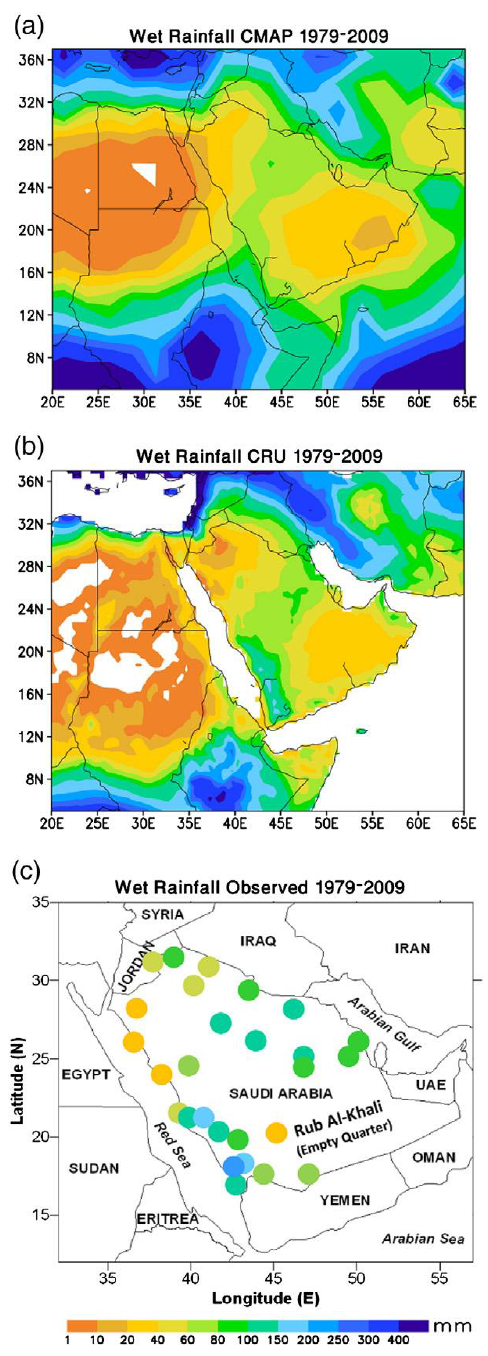
Figure 2. Spatial distribution of the wet season rainfall (mm) averaged for the period 1979–2009 obtained from the ( a ) CMAP; ( b ) CRU; and ( c ) station datasets